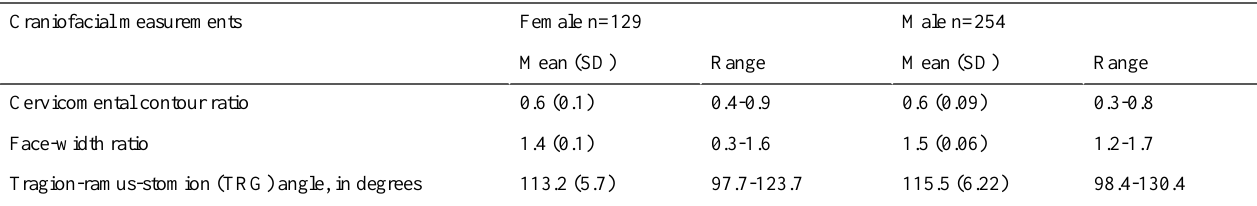
Table 6. Descriptive analysis of the craniofacial measurements on Spanish female and male subjects.